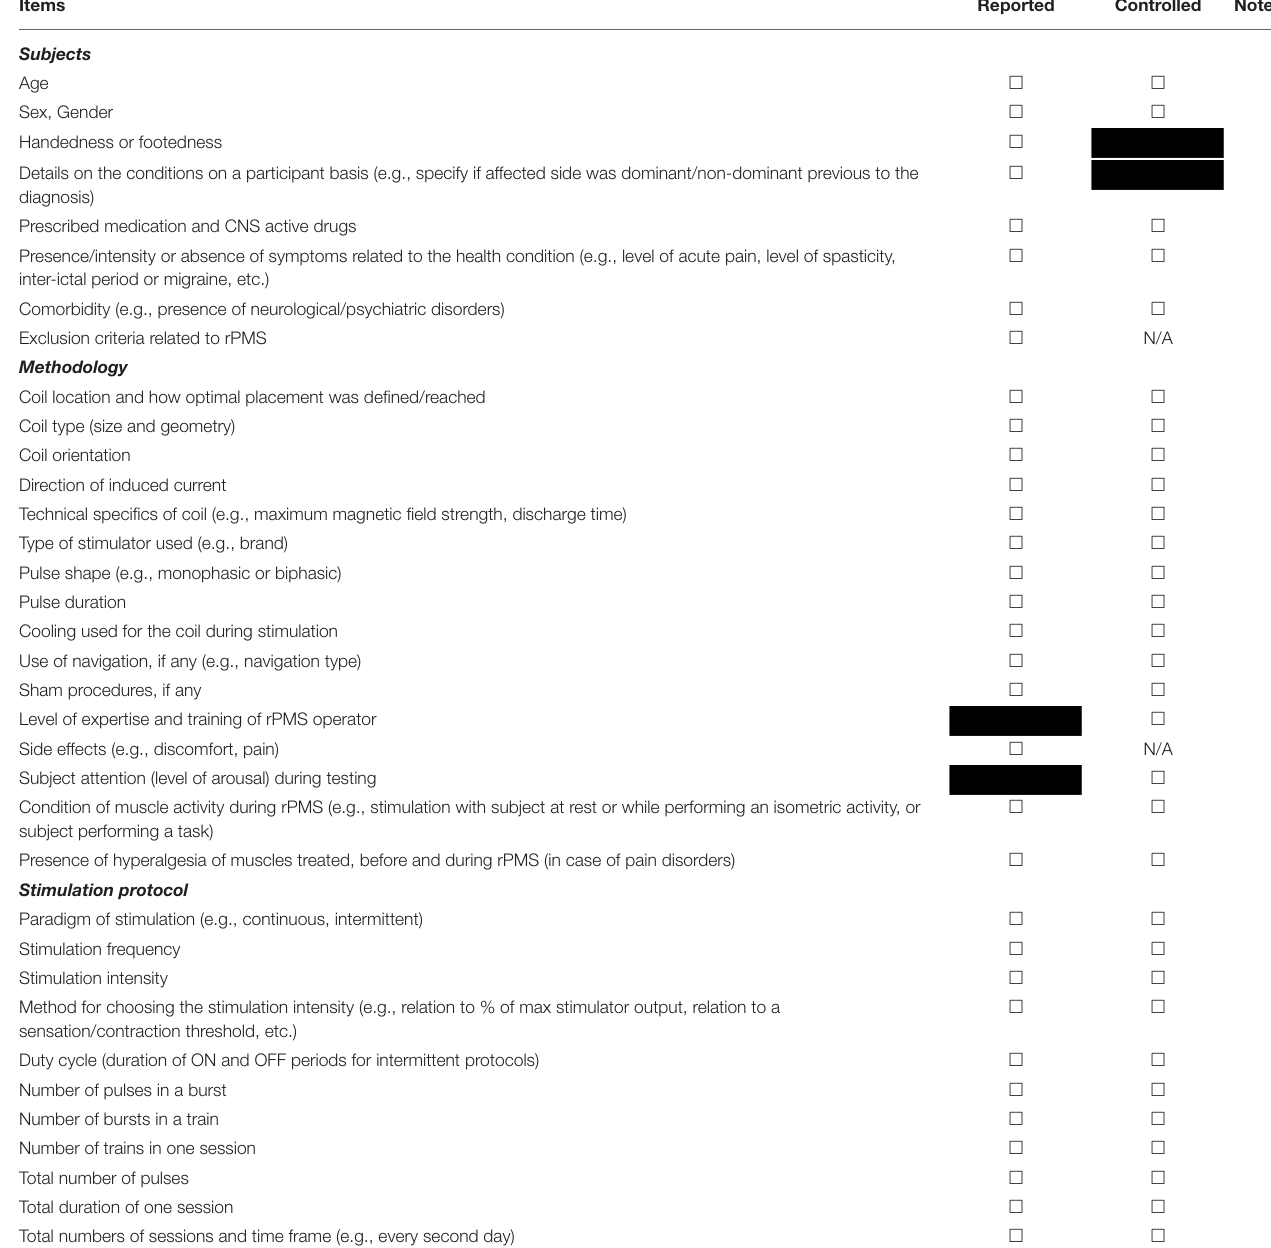
TABLE 4 | Consensual checklist obtained after the second round of the DELPHI study. Items Reported Controlled